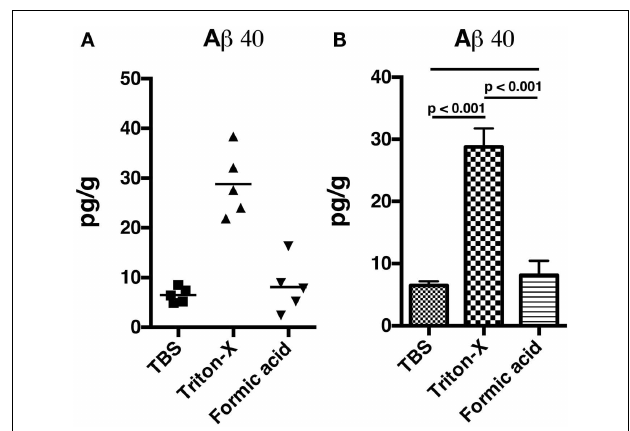
FIGUREA1 | Non-blast exposed control rats were sacrificed and hemibrains were fractioned intoTris buffered saline soluble,Triton X-100 soluble, and formic acid-extractable fractions. Levels of A β 40 (A,B) were determined by ELISA.Values are presented the ± SEM. Univariate ANOVA indicated that A β 40 levels differed between the fractions ( F 2,12 = 4.936; p < 0.001). Post-test comparisons between the groups are indicated (Tukey’s multiple comparisons test). NS indicates not significant. Note that most A β 40 is found in theTriton X-100 soluble